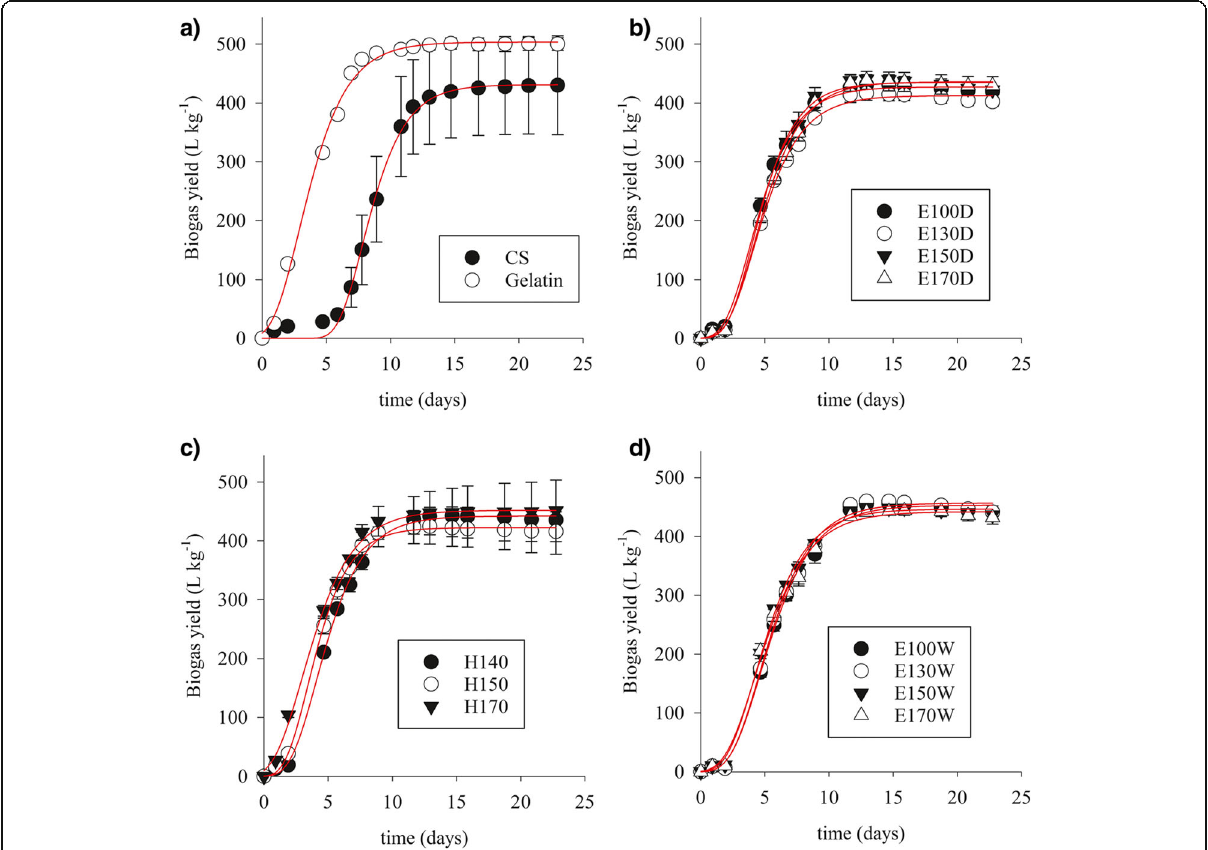
Fig. 5 Cumulative biogas production and MGM (red line) for CS and gelatin ( a ), samples extruded dry ( b ) treated hydrothermally ( c ) and extruded wet ( d